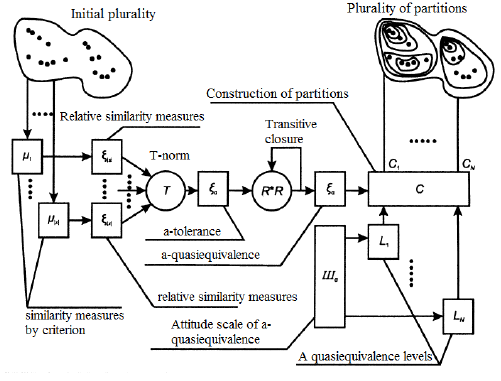
allocated extrema, to drop-out around the ex- treme values and second - by CF values, to group the extrema with the same values. Using Euclidean distance clustering criterion allows to groups the SOMA populations around the same extrema. After the (cid:28)rst clustering cri- terion developed mechanism delete all individu- als, except the Leader (extremum). It allows to dropout the sub-local